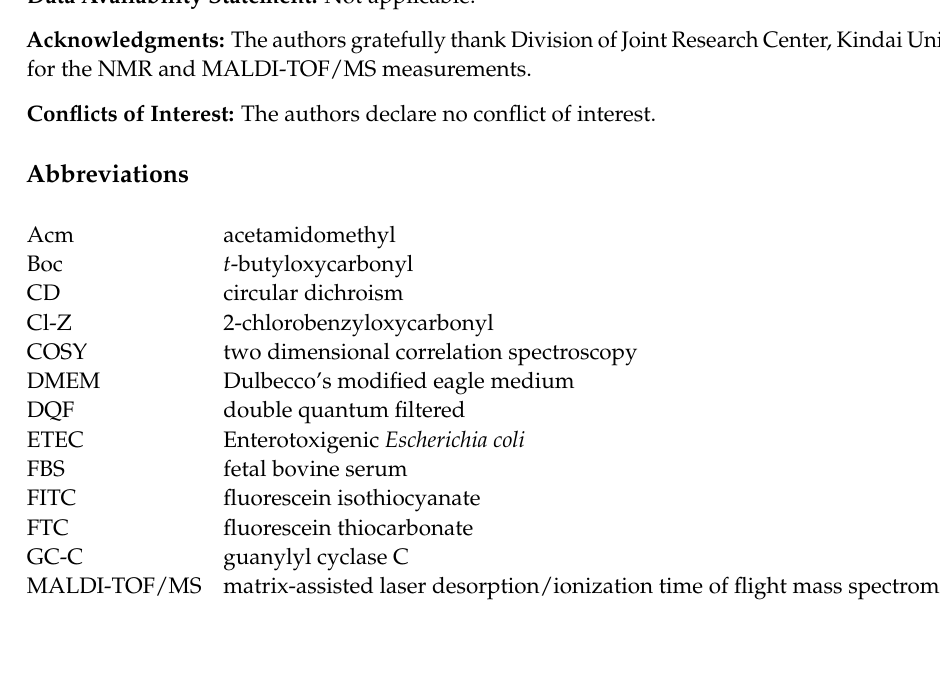
Figure S3: Ramachandran plots of the ϕ and ψ values of the amino acid residues which participate in the C-terminal region of the ST p molecules; Figure S4: HPLC profiles of the FITC (a) and reaction mixtures (b) with the [Mpr 5 ,D-Lys 16 ]-ST p (5-17)